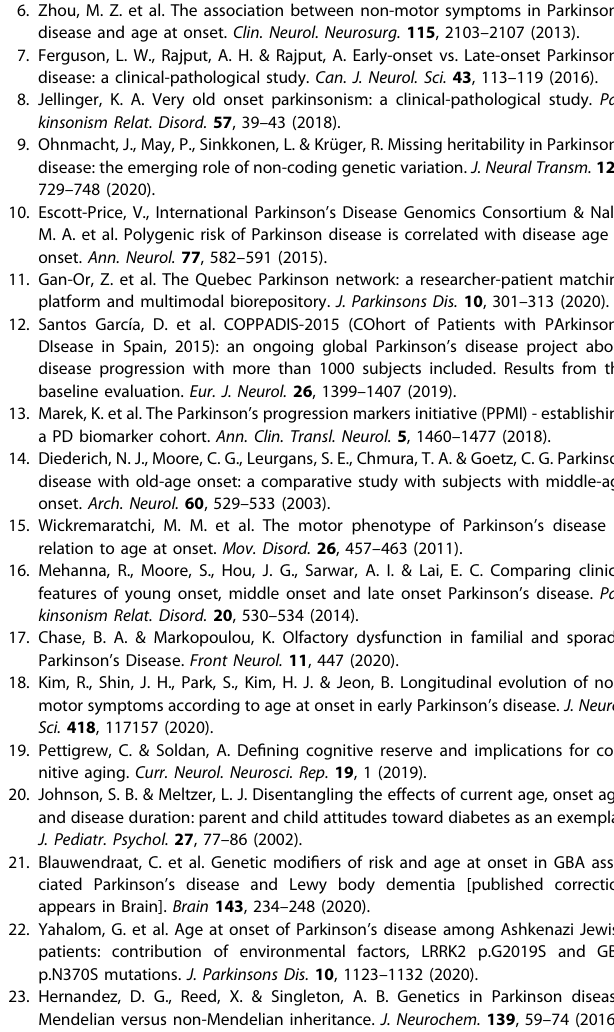
Fig. 3 Description of the study design and study dataset. PD individuals with Parkinson ’ s disease, HC healthy